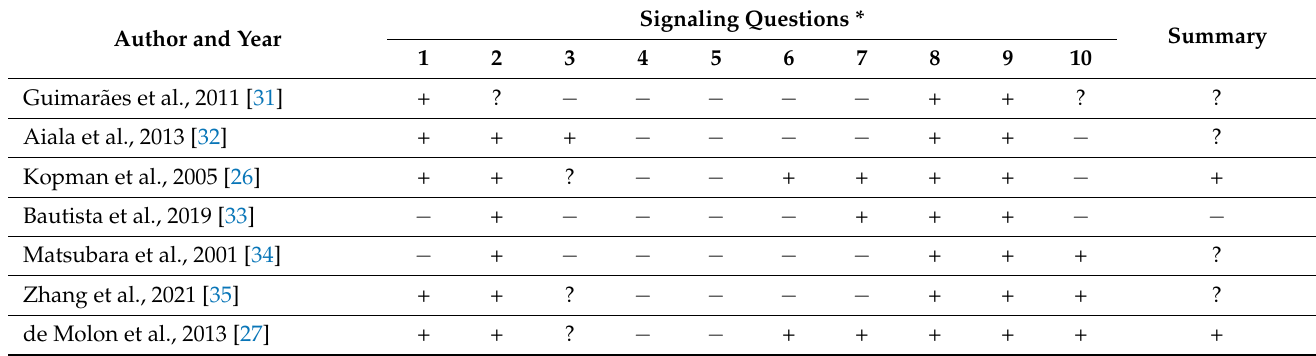
Table 1. Summary of the risk-of-bias according to the Systematic Review Centre for Laboratory Animal Experimentation (SYRCLE) RoB